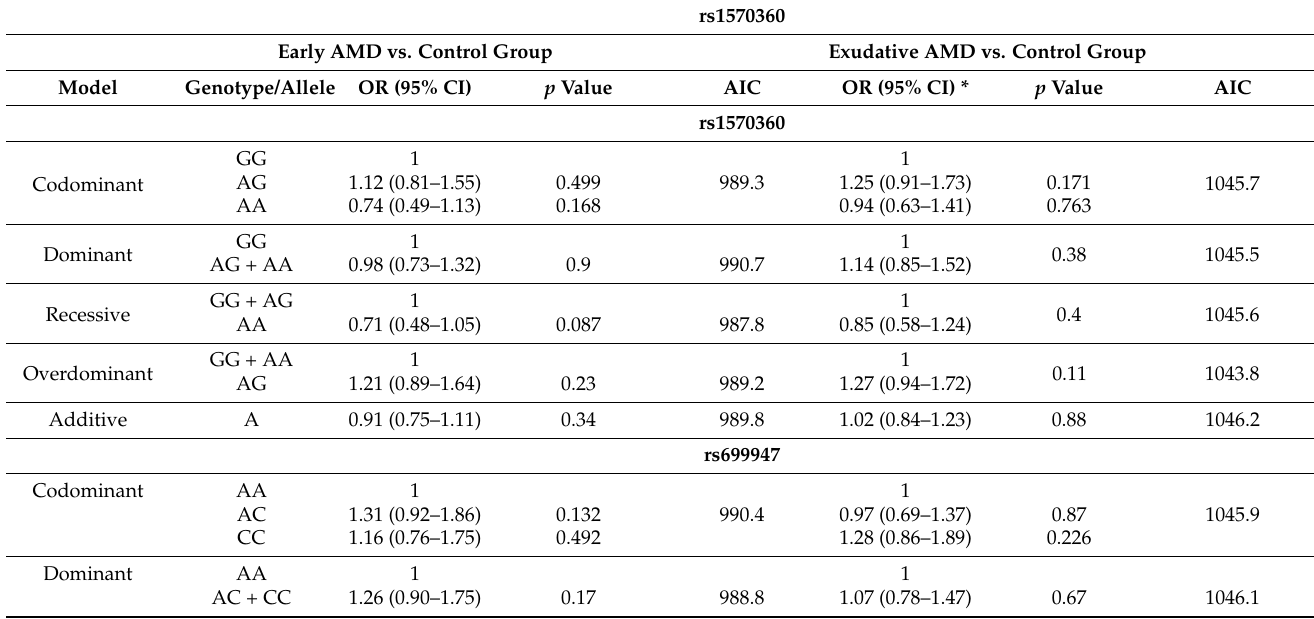
Table 3. Binomial logistic regression analysis of VEGFA (rs1570360, rs699947, rs3025033, and rs2146323) in early and exudative AMD and control